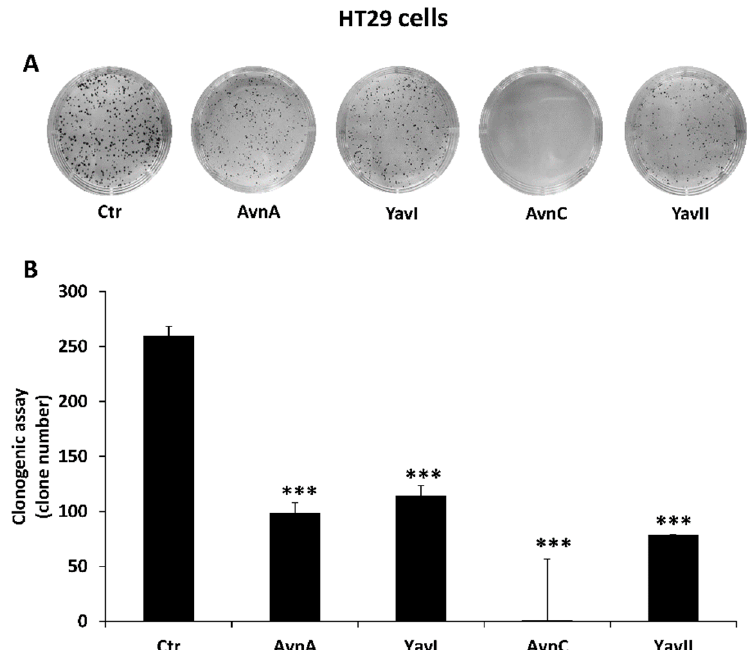
Figure 3. Natural and yeast-derived avenanthramides reduce clonogenicity of HT29 colon cancer cells. ( A ) Representative images of colony formation capability of HT29 cells in response to Avn-A, Avn-C, YAvnI and YAvnII (200 μ M) for 10 days; ( B ) Number of colonies in HT29 cells in response to natural or yeast derived avenanthramides over control. *** p < 0.001.